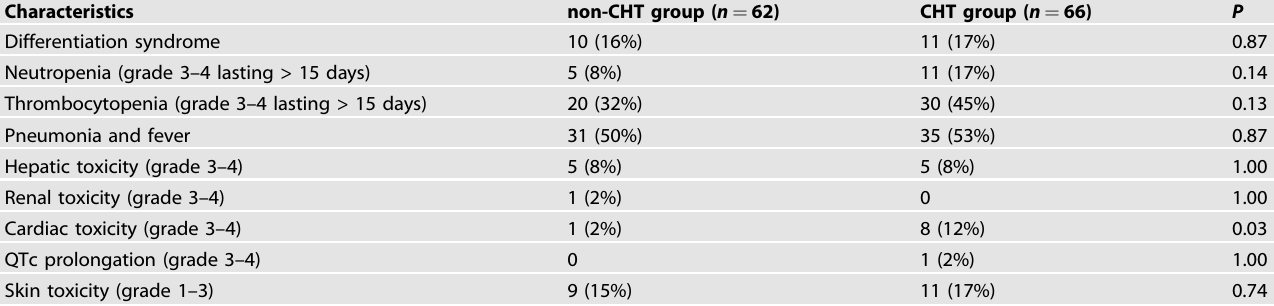
Table 3. Incidence of all non-hematological and hematological toxic effects.